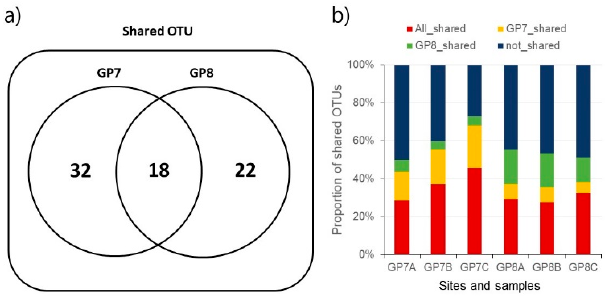
Figure 2. Shared core OTUs between sampling sites ( a ) and among samples ( b ).